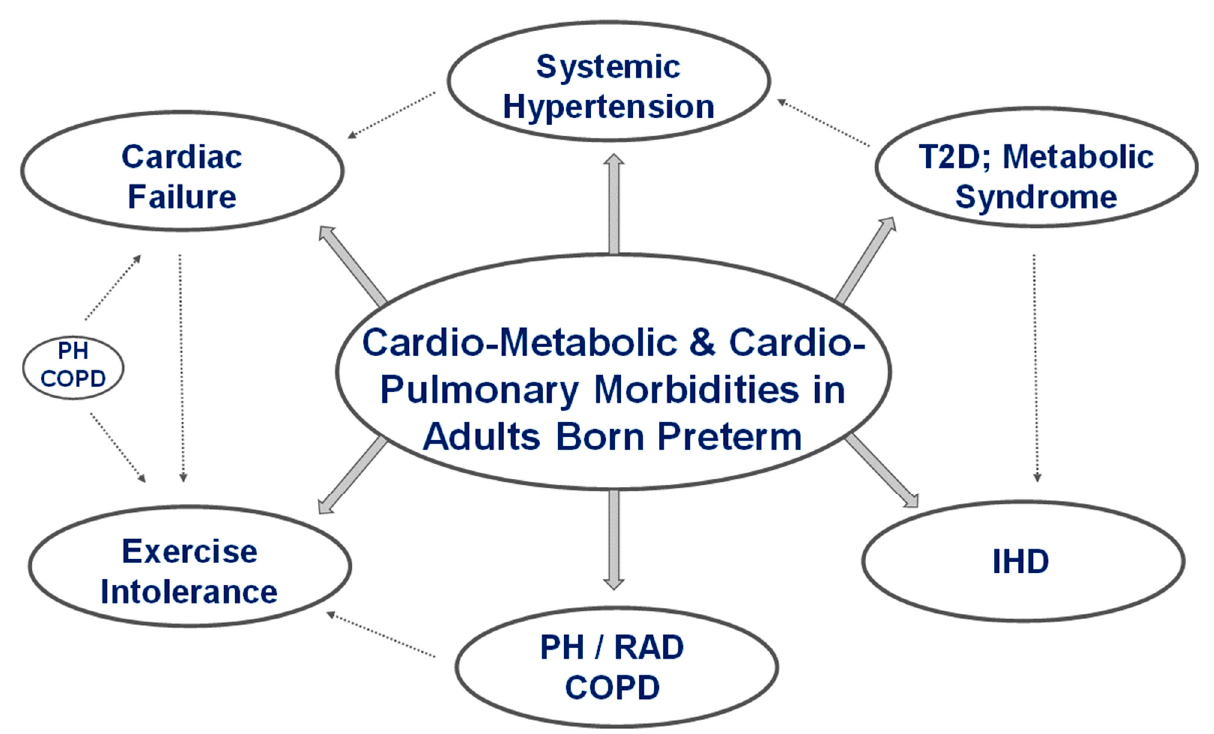
Figure 2. Diaphragmatic representation of clinical morbidities seen following premature birth in adults born preterm. The interconnectedness of the cardiac and pulmonary systems means that the heart carries the brunt of the effects of pulmonary morbidity. Early onset of type 2 diabetes and metabolic syndrome are risk factors for ischemic heart disease and systemic hypertension in adulthood. Systemic and pulmonary hypertension and chronic lung disease (COPD) are risk factors for the development of cardiac failure. Pulmonary hypertension, reactive airway disease and COPD could trigger exercise intolerance in preterm-born adults. Abbreviations: RAD—reactive airway disease, COPD—chronic obstructive airway disease, T2D—type II diabetes, PH—pulmonary hyper- tension, IHD—ischemic heart disease. (copyright: Vasantha Kumar. H.S).